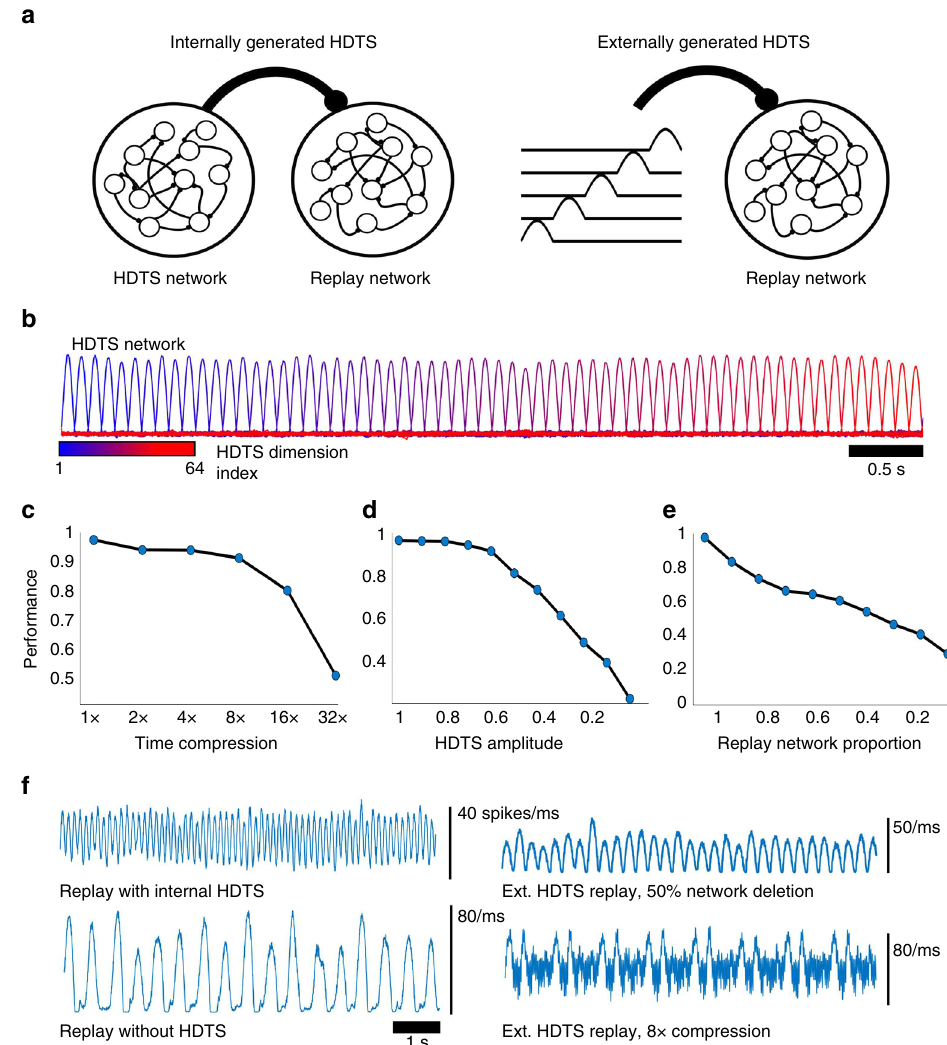
Fig. 5 Using spiking neural networks for pattern storage and replay: movie replay. a Two types of networks were trained to replay an 8 s clip from a movie. In the internally generated HDTS case, both an HDTS and a replay network are simultaneously trained. The HDTS projects onto the replay network similar to how HVC neurons project onto RA neurons in the birdsong circuit. The HDTS confers an 8 Hz oscillation in the mean population activity. In the externally generated HDTS case, the network receives an HDTS supervisor that has not been trained, but is simple to manipulate and confers a 4 Hz oscillation in the mean population activity. b The HDTS consists of 64 pulses generated from the positive component of a sinusoidal oscillator with a period of 250 ms. The color of the pulses denotes its order in the temporal chain or equivalently, its dimension in the HDTS. c The external HDTS is compressed in time which results in speeding up the replay of the movie clip. The time-averaged correlation coef fi cient between the teaching signal and network output is used to measure performance. d The HDTS amplitude for the network with an internal HDTS was reduced. The network was robust to decreasing the amplitude of the HDTS. e Neurons in the replay network were removed and replay performance was measured. The replay performance decreases in an approximately linear fashion with the proportion of the replay network that is removed. f The mean population activity for the replay networks under HDTS compression, removal, and replay network